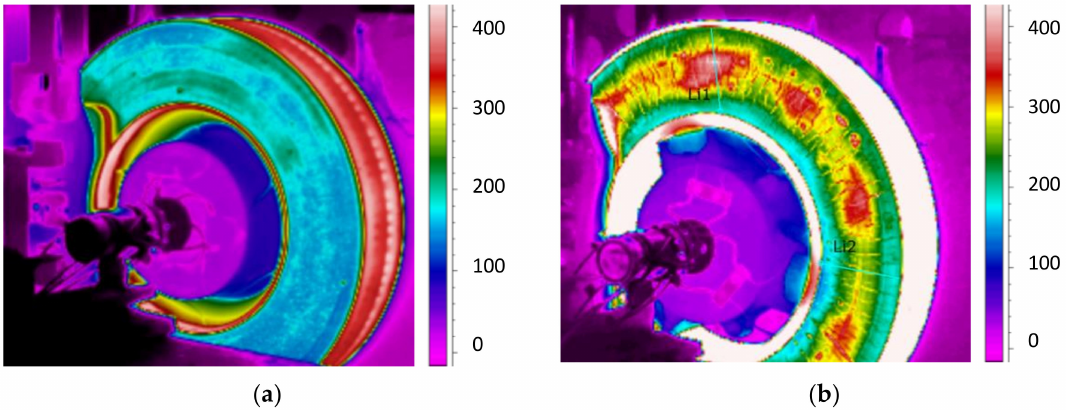
Figure 15. Thermal image of the brake disc, type: ( a ) 590 × 110 (new disc), ( b ) 640 × 110 (worn disc).